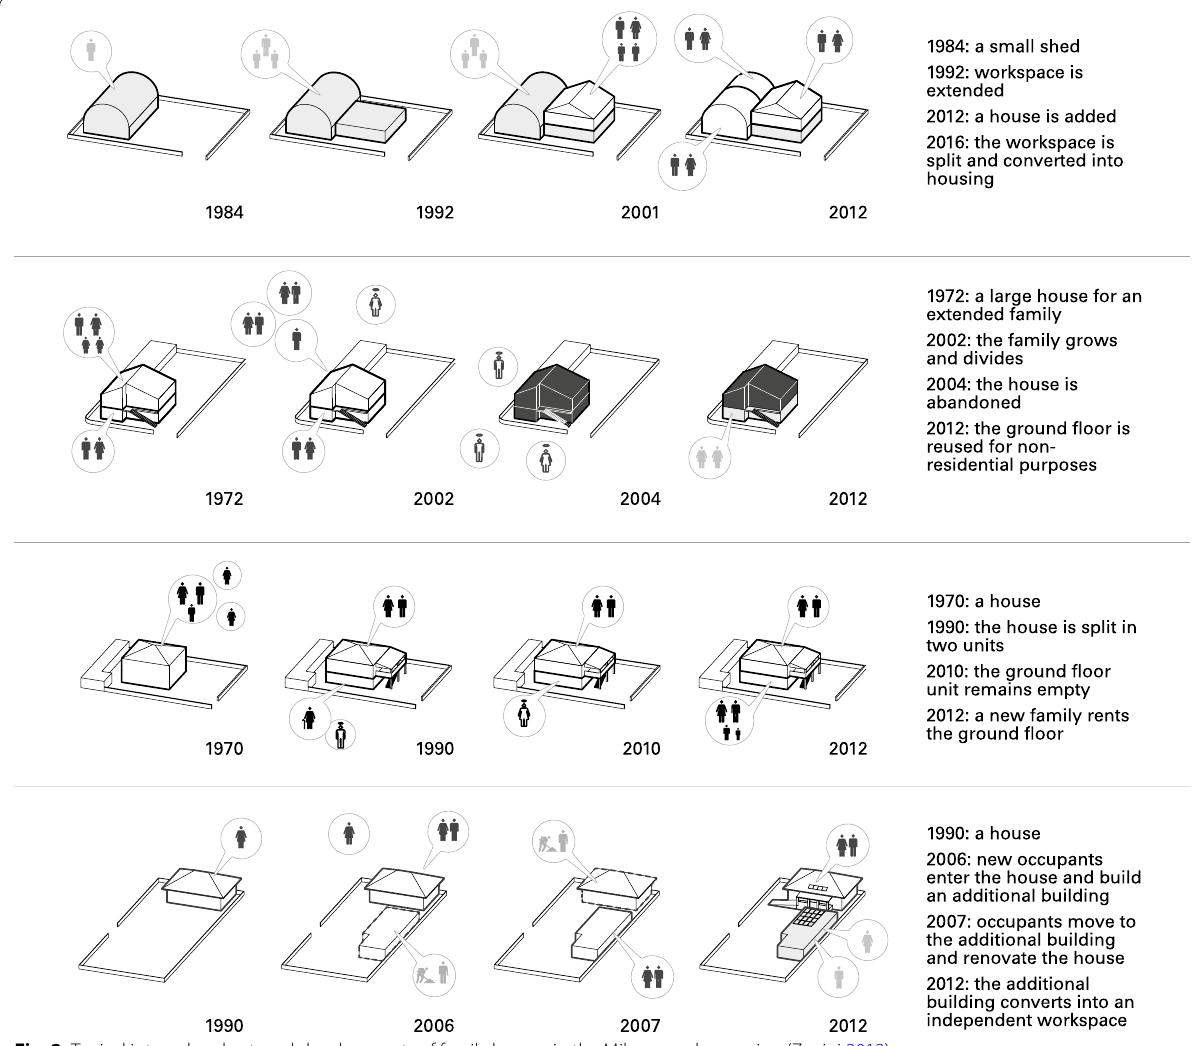
Fig. 2 Typical internal and external developments of family houses in the Milanese urban region (Zanini